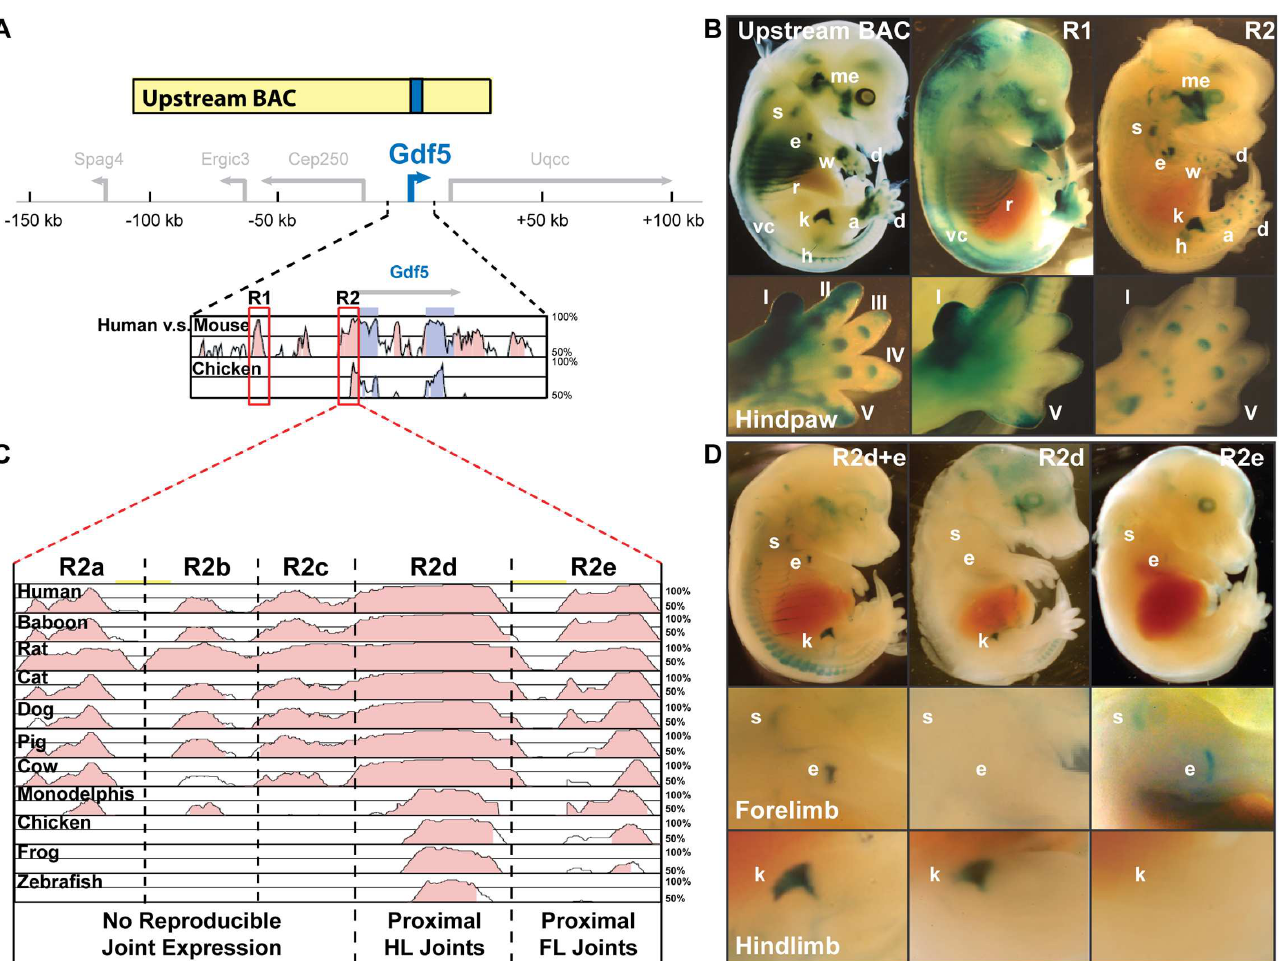
Fig 2. Two upstream regulatory elements drive expression in axial tissue domains (R1) and limb joints (R2); while separatesub-domains of R2 control distinct positions with limbs. ( A ) Evolutionarily conservednon-codingregions(pink peaks) were identifiedupstream of Gdf5 coding regions (blue peaks), based on a criterion of 70% or greater nucleotide sequenceidentity between human, mouse, and chicken sequenceover a region of 300 bp or more. ( B ) Two distinct conservednon-coding peaks (R1 and R2; red-boxesin A ) were tested for enhancer activity at E14.5 and compared to lacZ expressiondrivenby the UpstreamBAC. R1 drove expressionin axial tissues such as the ribs (r), vertebral column (VC), and anterior mesenchyme of the paw, whileR2 drove expression in limb joints such as the shoulder(s), elbow(e), wrist (w), hip (h), knee (k), ankle (a), and digit regions (d). Bottom panelshows zoom-inimages of hindpaws.( C ) Comparisonof genomicsequencesof R2 from twelve species with mouse as reference. Based on patterns of conservation betweenspecies, R2 was dividedinto five sub-regions (a-e). ( D ) Transgenicembryos at E14.5 from sub- regions R2d+e (left), R2d (middle), and R2e (right). Sub-regionR2d drove hindlimb(HL) joint expression, whilesub-regionR2e drove forelimb (FL) joint expression. Panels belowshow zoom-inimages of forelimb (shoulder,elbow)and hindlimb(knee) from R2d+e, R2d, and R2e